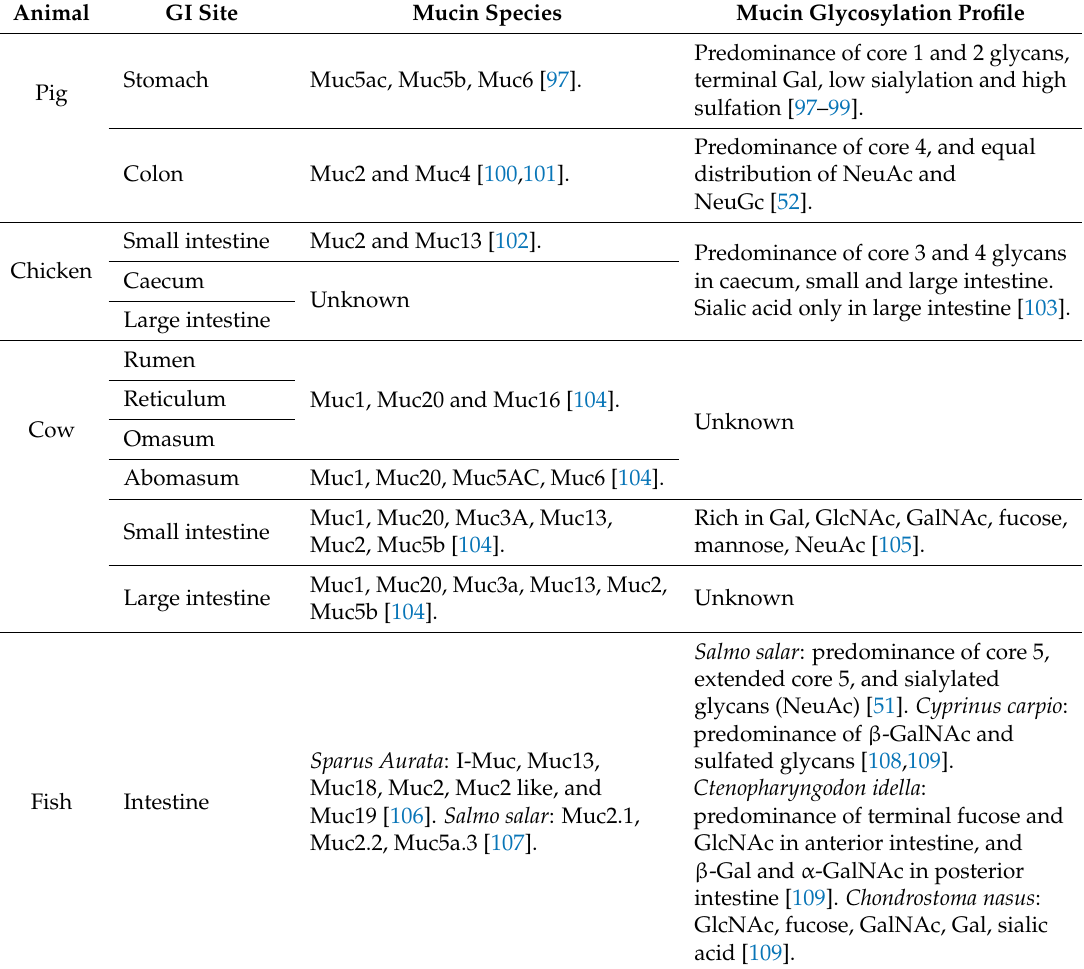
Table 1. Gastrointestinal mucin species and glycosylation profile in farmed